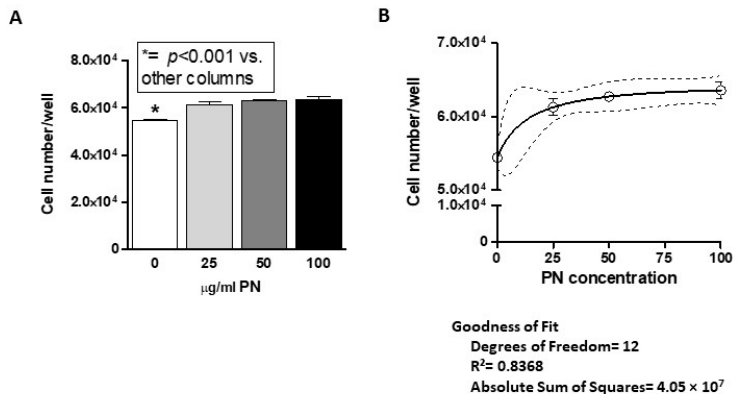
Figure A1. ( A ) Dose–response assay of primary gingival fibroblast with increasing doses of PN after 48 h of culture. Cell number per culture well is reported on the y axis. ( B ) The curve fitted on the cell growth data shows that a plateau of effect is reached with 100 μ g/mL.